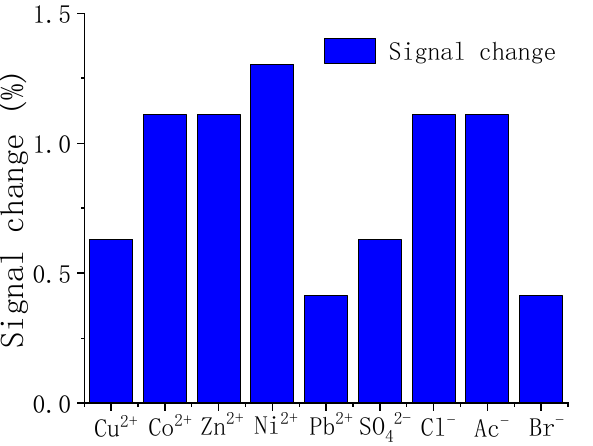
Figure 9. Influence of interfering ions (Cu 2+ , Co 2+ , Zn 2+ , Ni 2+ , Pb 2+ , SO 42− , Ac − , CI − , and Br − ).